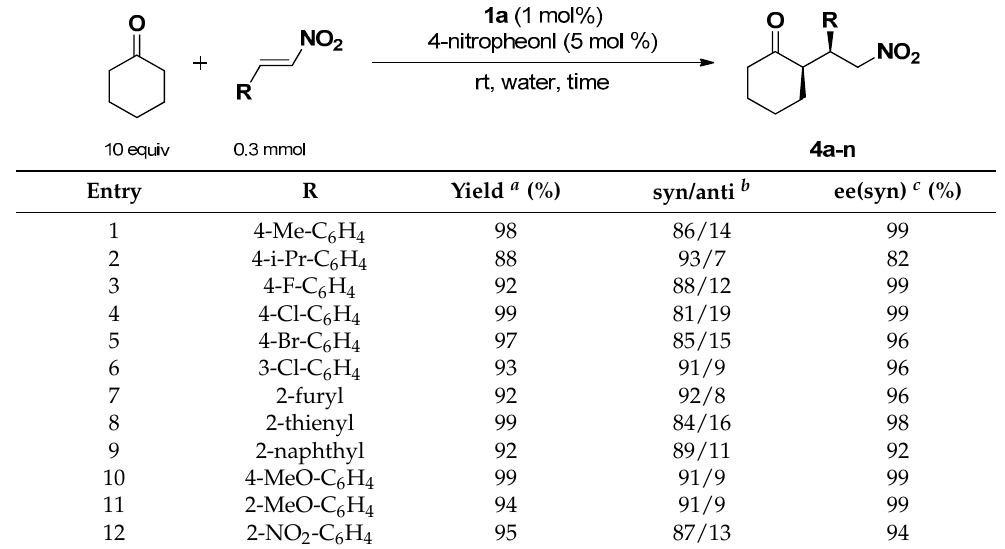
Table 3. Asymmetric Michael reaction of the cycloketones and various α , β -unsaturated nitroalkenes using the thiourea catalyst.